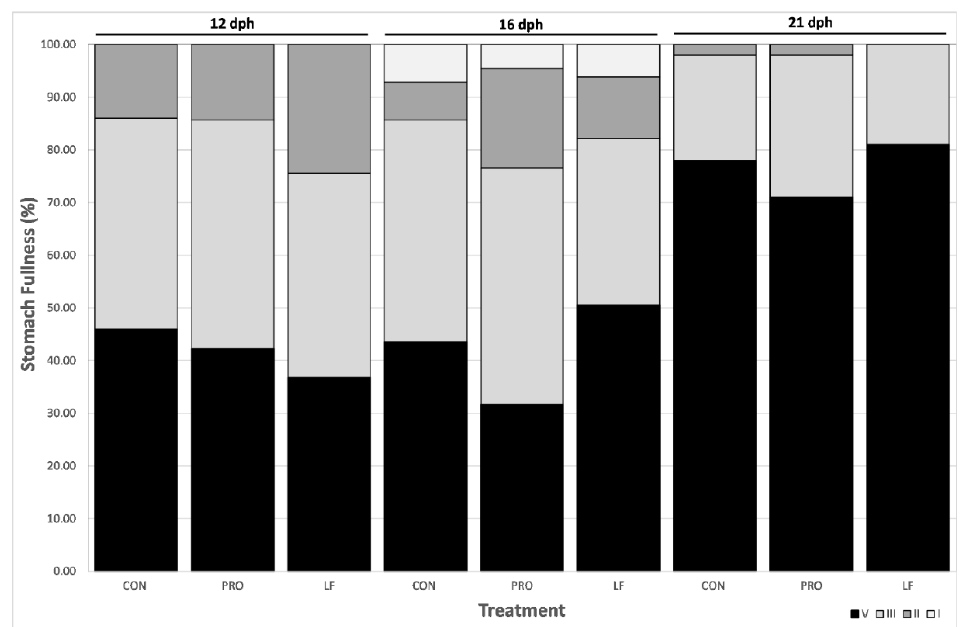
Figure 3. Larval stomach fullness from three treatments at days 12 ( n = 40), 16 ( n = 40), and 21 dph ( n = 100). Expressed in percentage (1 to 4, 4 being the maximum fullness, from darkest to lightest grey).